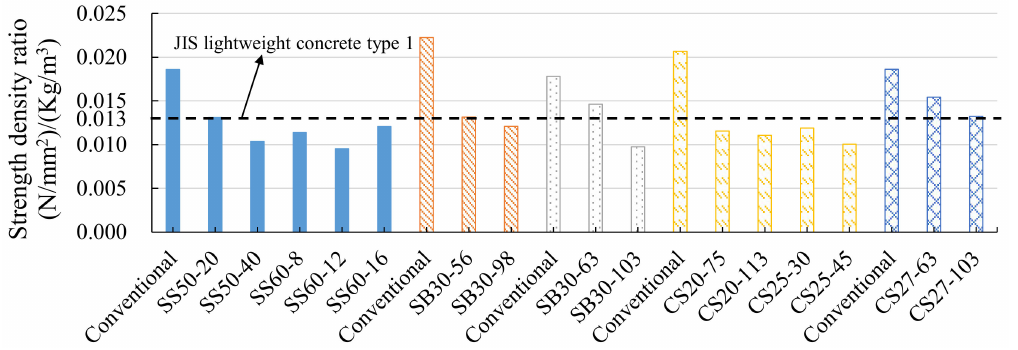
Figure 23. Strength density ratio of concrete specimens.